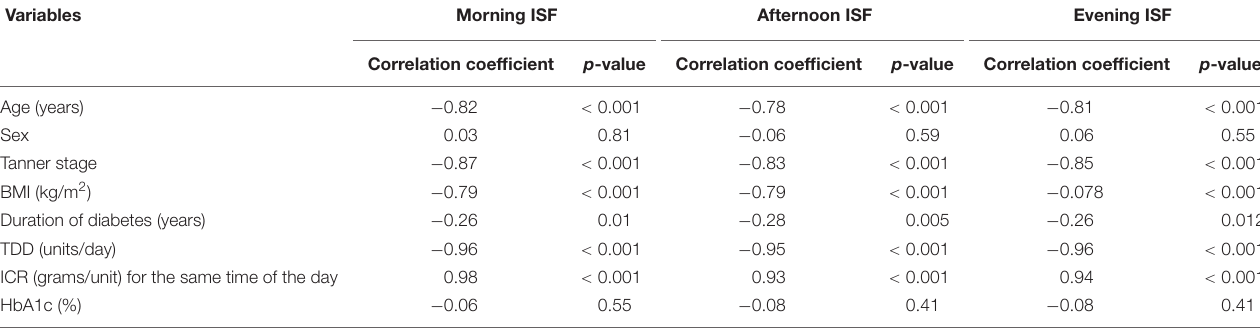
TABLE 5 | Correlations between the insulin sensitivity factors for different times of the day and some clinical variables of the study participants. Variables Morning ISF Afternoon ISF Evening ISF